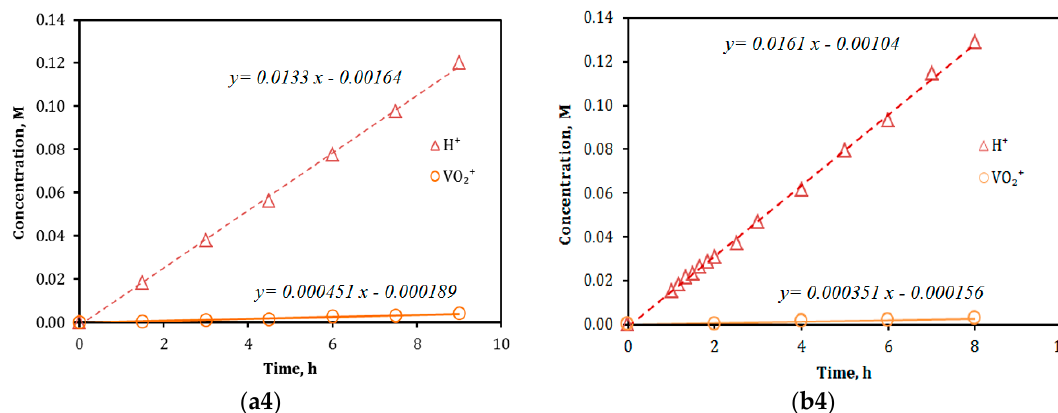
Figure 2. Results of ion diffusion measurements for VPG ( a1 – a4 ) and Nafion-117 ( b1 – b4 ) membranes using feeds of 2 M vanadium sulfate solutions in 2 M H 2 SO 4 : ( a1 , b1 )—V 2+ vs. H + , ( a2 , b2 )—V 3+ vs. H + , ( a3 , b3 )—V 4+ (VO 2+ ) vs. H + , and ( a4 , b4 )—V 5+ (VO 2+ ) vs. H + . Table 1. Ion fluxes, overall ion transport coefficients, and proton transport selectivity over vanadium ions on the VPG and Nafion membranes determined by the solution diffusion experiments. Membrane: